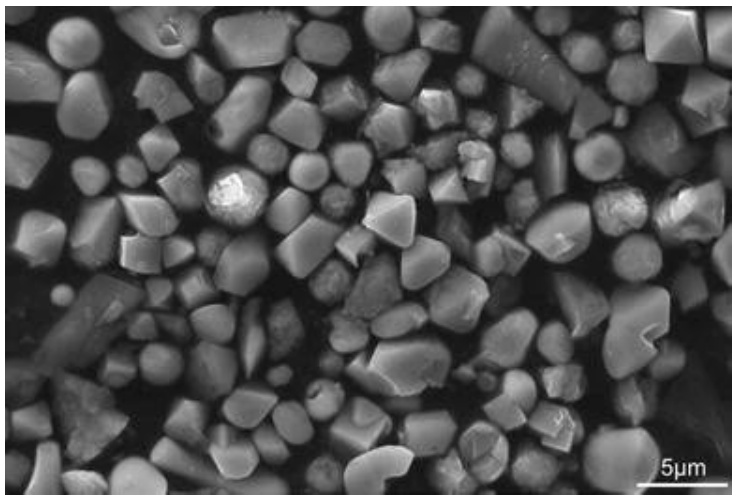
Figure 8. Morphologies of typical sulphide and nitride inclusions in low-sulphur spring steels [95]. Copyright 2016, Springer Nature.